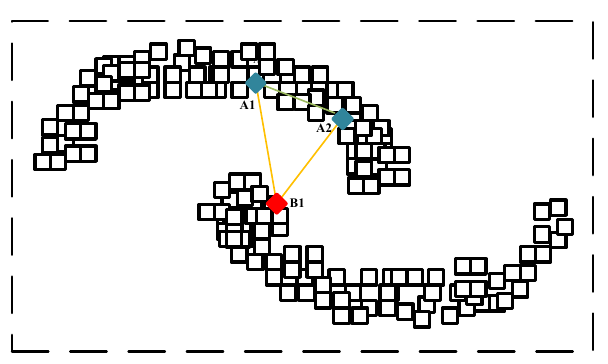
Figure 2. The visualization of multiple sub-manifolds in local sample space. Points A1, A2 and B1 are from two different manifolds. The green solid line connects two homogeneous manifold samples, i.e. the similarity between two homogeneous manifold samples, and the yellow solid line links two heterogeneous manifold samples, i.e. the similarity between two heterogeneous manifold samples. Best view in